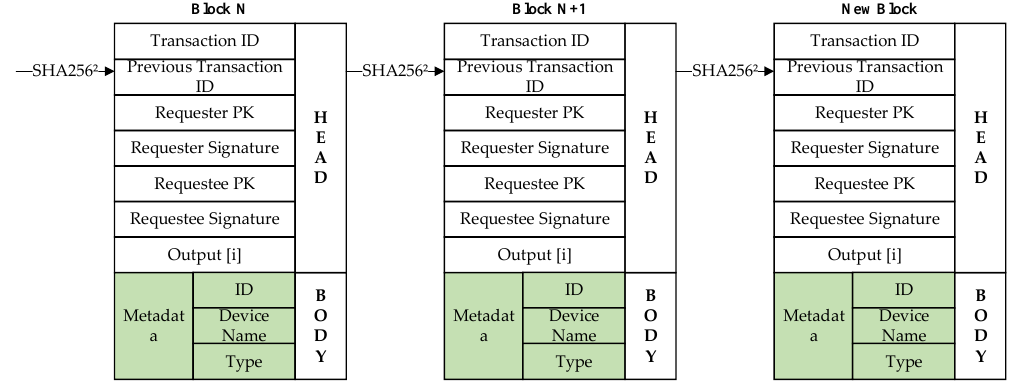
Figure 2. Transaction data structure.